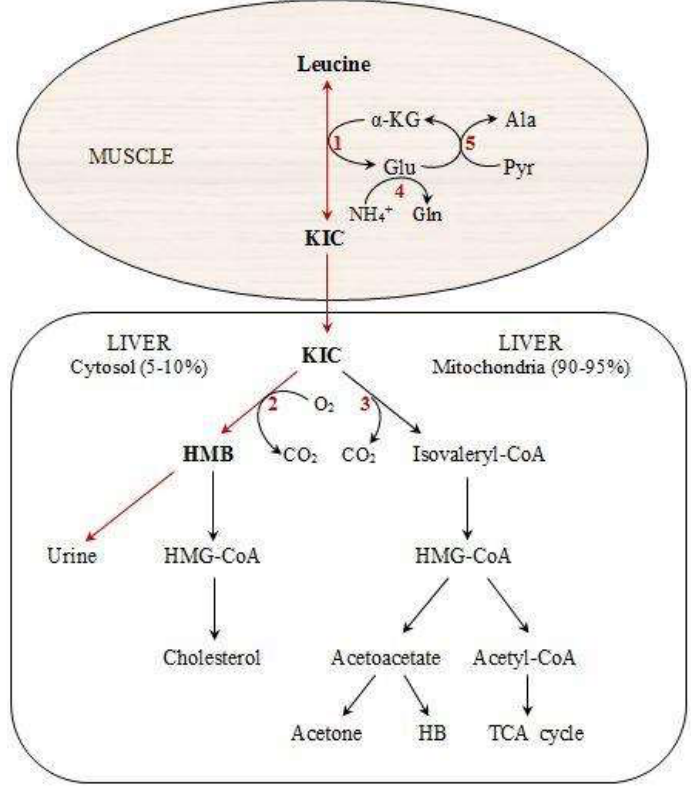
Figure 1. Pathways of HMB metabolism from the amino acid, leucine. Modified from Nissen and Abumrad [31]. HMB: Beta-hydroxy-beta-methylbutyrate, KIC: Alpha-ketoisocaproic acid, HB: Beta-hydroxybutyrate, HMG-CoA: 3-hydroxy-3-methyl-glutaryl-CoA, Ala: Alanine, Pyr: Pyruvate, 1: branched-chain amino acid (BCAA) aminotransferase, 2: KIC dioxygenase, 3: Branched-chain alpha-keto acid dehydrogenase (BCKAD), 4: Glutamine synthetase, 5: Alanine aminotransferase.